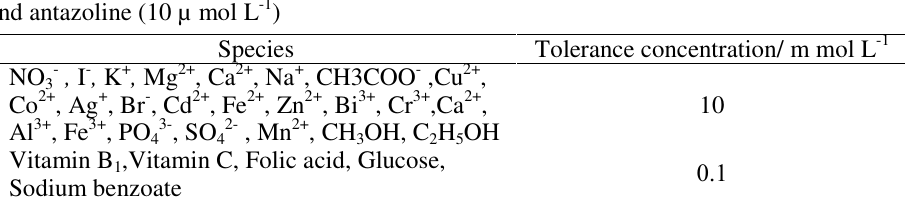
Table 3. Maximum tolerable concentration of interfering species with naphazoline (10 µ mol L -1 ) and antazoline (10 µ mol L -1 ) Species Tolerance concentration/ m mol L